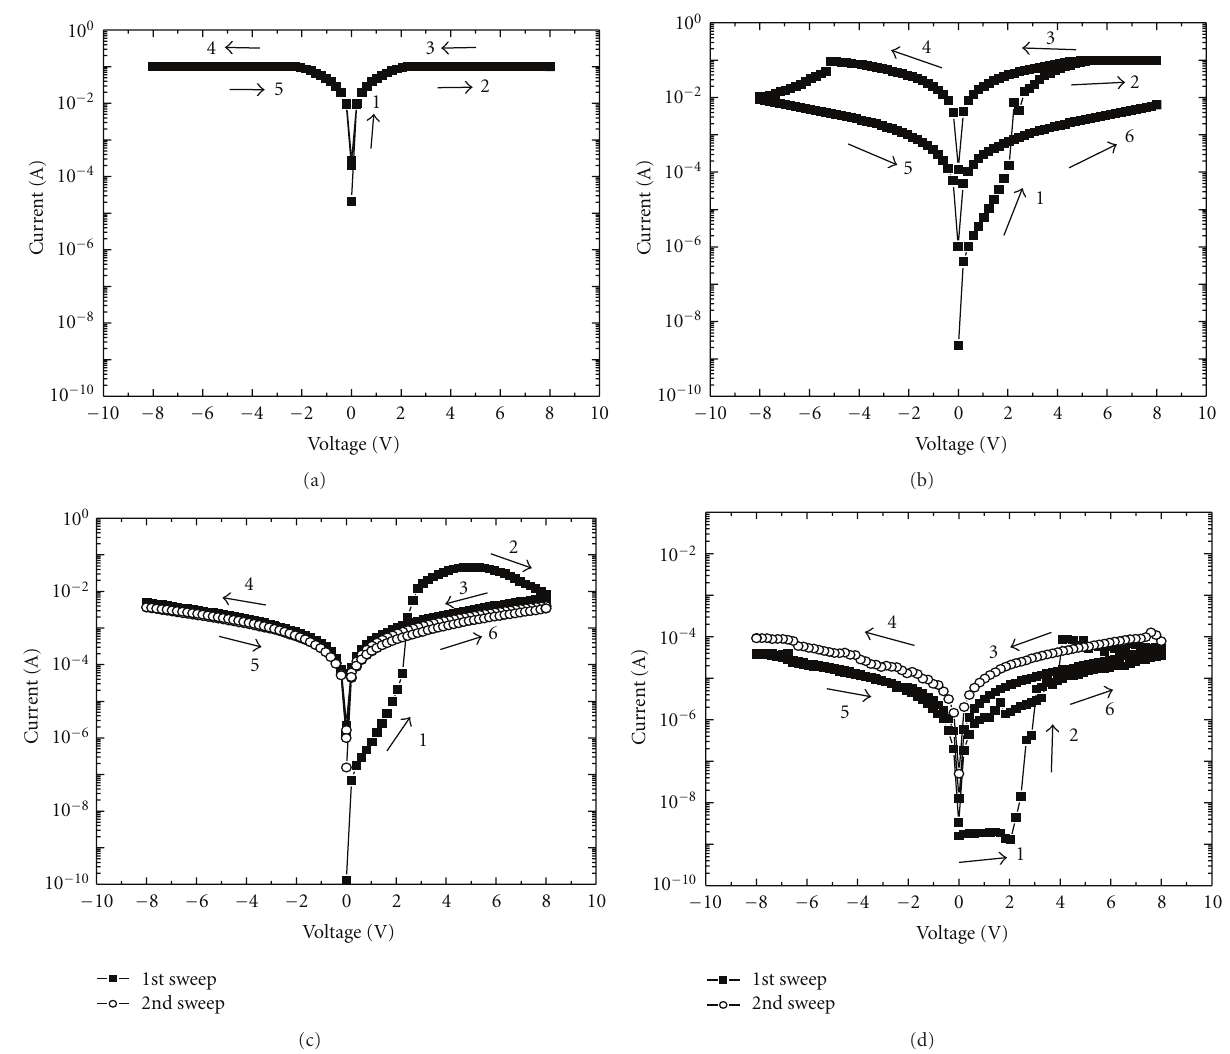
Figure 2: I-V response of the Al/PMMA/Al devices as a function of PMMA thickness: (a) 7.5nm, (b) 17 nm, (c) 22 nm, and (d) 140 nm. The devices were fabricated using CB as solvent. It can be appreciated that the I-V response changes as a function of the PMMA